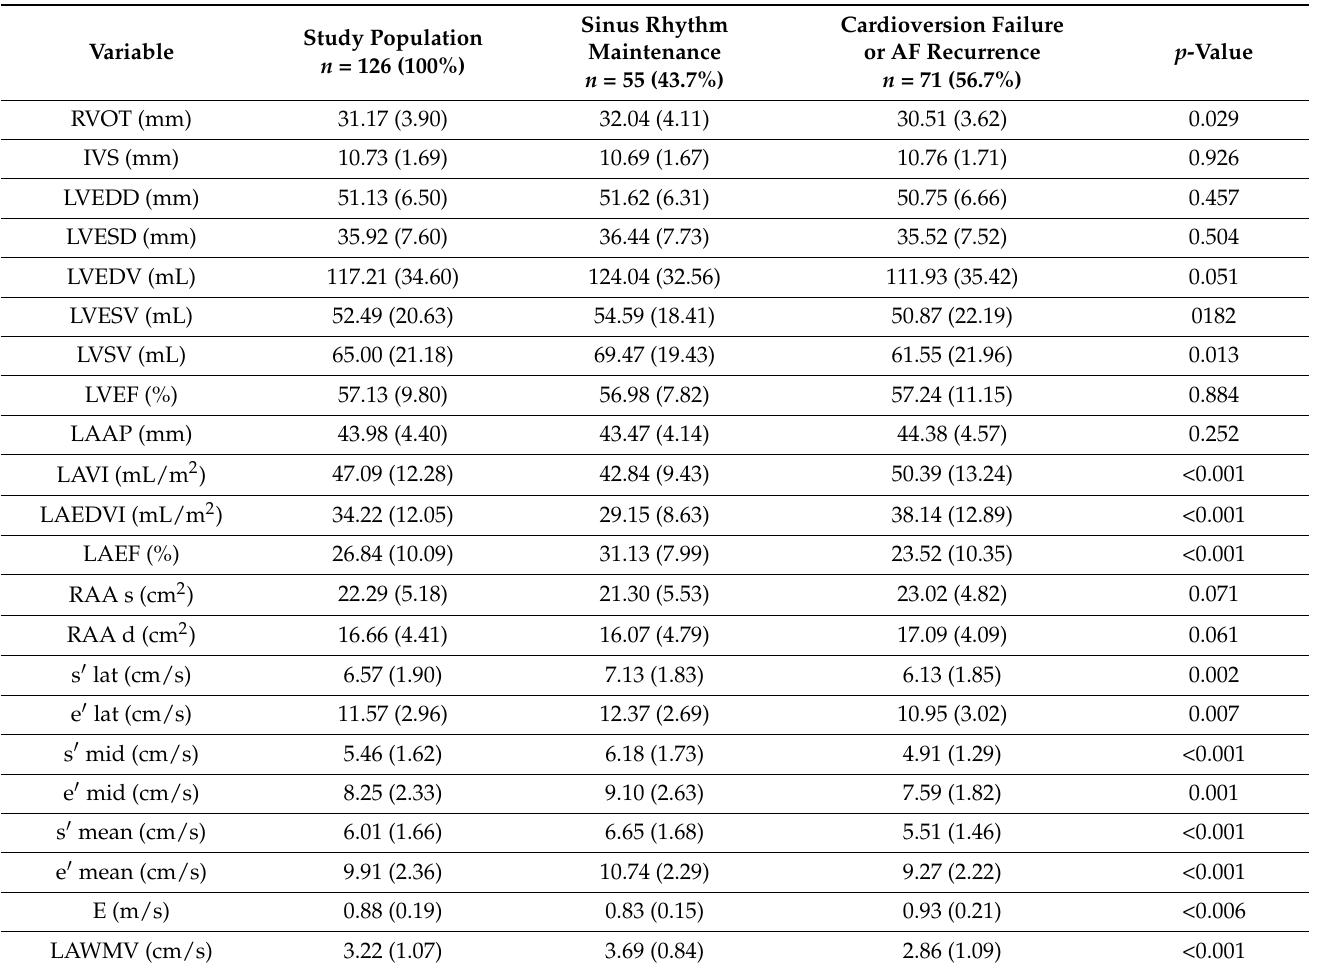
Table 2. Echocardiographic